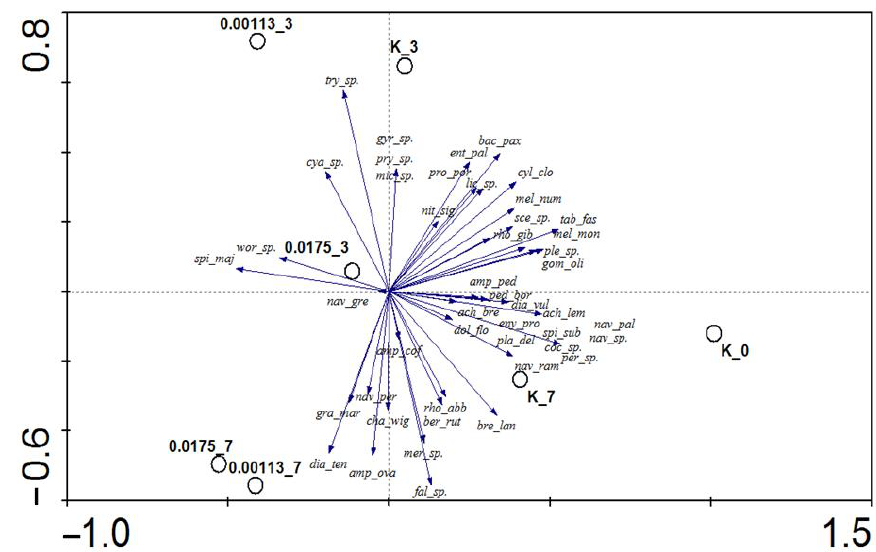
Figure 4. PCA (principal component analysis) of microphytobenthos species composition (based on the abundance data) from control and [BMIM]Cl treatments cultures. Percentage explained variation λ 1 = 26%, λ 2 = 22.4% λ 3 = 17.9%. K indicates control cultures, 0.00113 and 0.0175 indicate cultures of lower (1.13 × 10 − 3 g · dm − 3 ) and higher (1.75 × 10 − 2 g · dm − 3 ) tested [BMIM]Cl concentrations, respectively. The number after the underline denotes the day of the experiment. Taxon codes are included in Table A1 in Appendix A.